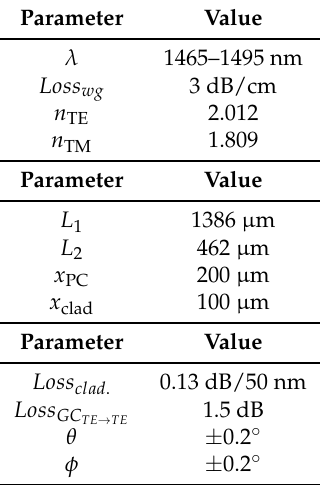
Table 2. Showing generic parameters that are valid for all devices.